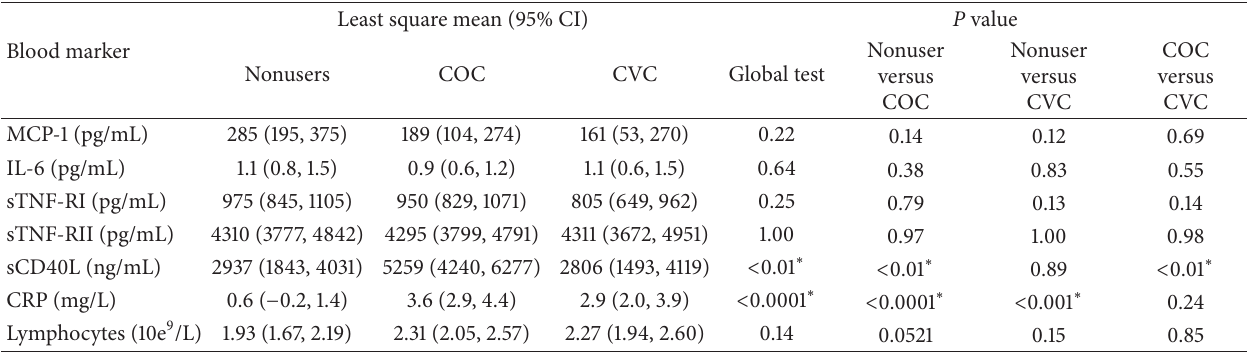
Table 2: Multivariate analysis of the blood inflammatory biomarkers for the selected recruited subjects.